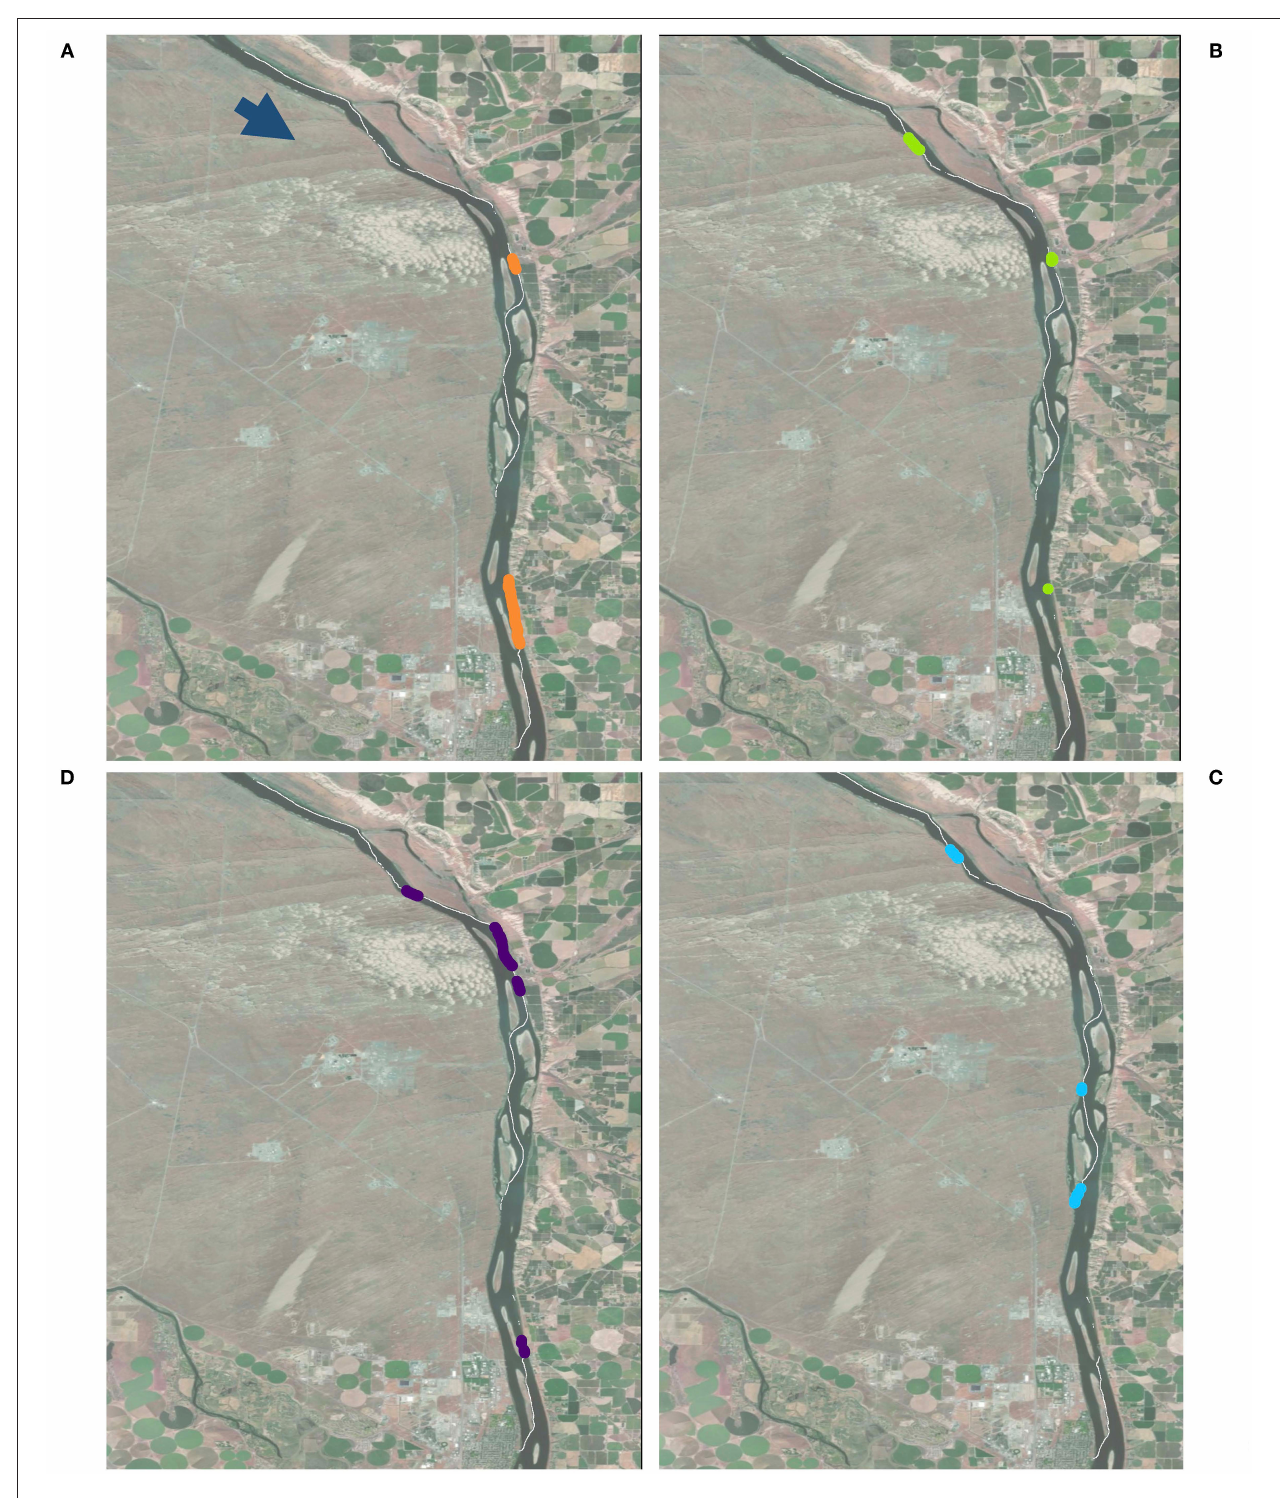
FIGURE 9 | Anomalies found July 3–17 that were (A) Category 1 (high EC; low temperature), (B) Category 2 (high EC; high temperature), (C) Category 3 (not anomalous EC; high temperature), and (D) Category 4 (not anomalous EC; low temperature) are all present during this time range, but each category of anomaly is only present in a few locations. The white line shows all the paths traversed during this time period. Map data from Google, Landsat.